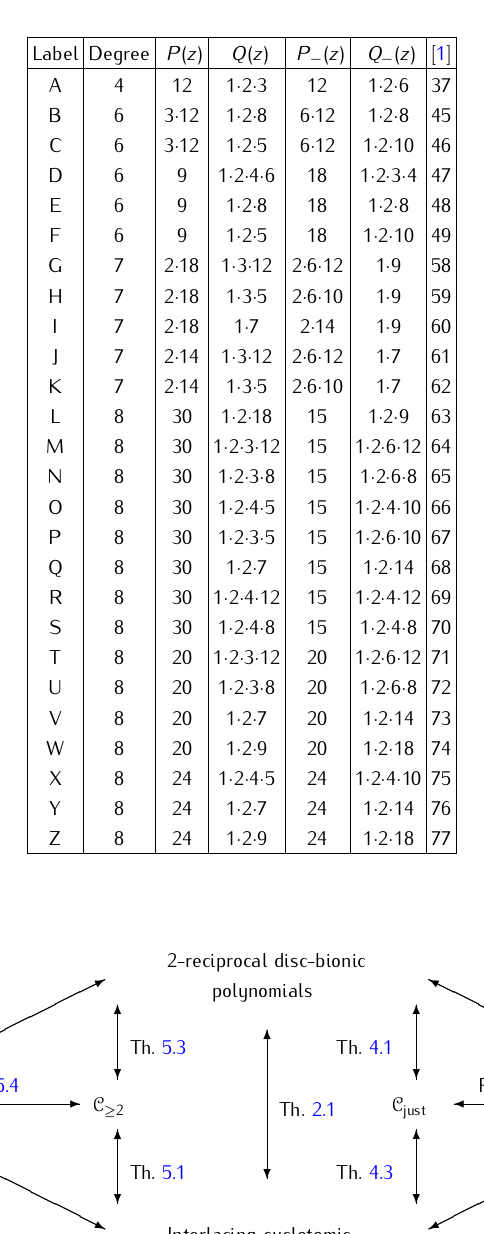
Table 2. The 26 sporadic cases of primitive interlacing cyclotomic pairs. The numbers in the P ( z ) ,Q ( z ) columns refer to products of cyclotomic poly- nomials n ↔ Φ n . The final column refers to [1, Table 8 . 3 ]. Also, P − ( z ) ,Q − ( z ) are ( − 1) deg P P ( −z ) , ( − 1) deg Q Q ( −z ) , if necessary interchanged so that Q − (1) = 0 .